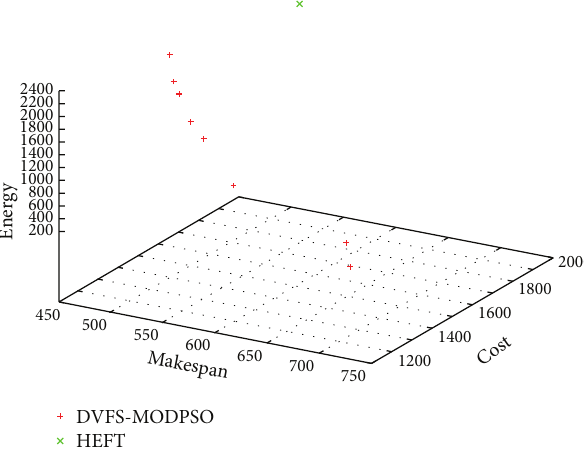
Figure 3: Obtained non-dominated solutions for the synthetic workflow.